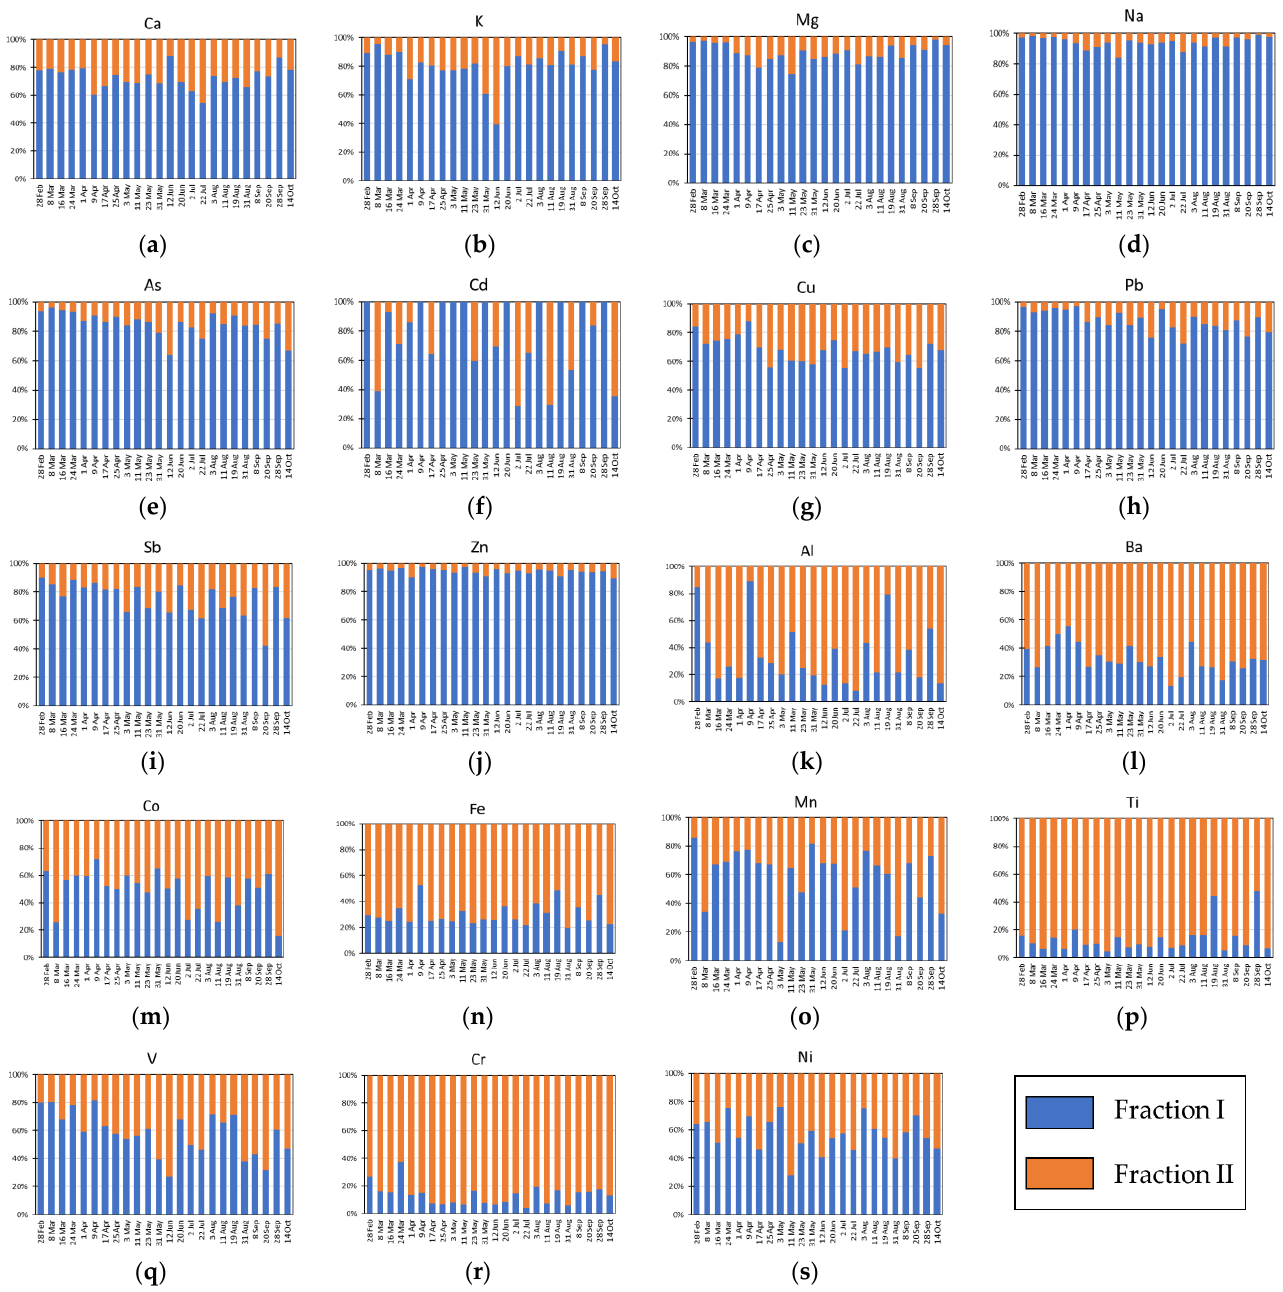
Figure 5. Extraction percentages obtained by means of the sequential extraction procedure on analytes prevalently having different origins: ( a – d ) marine; ( e – j ) anthropogenic; ( k – q ) crustal; ( r , s ) crustal from enriched soils of southwest Greenland.